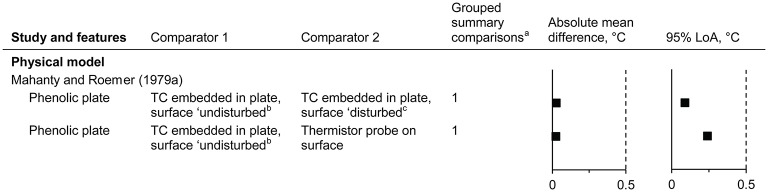
Temperature disturbance of the surface underlying a surface sensor (absolute mean difference and 95% limits of agreement). LoA, limits of agreement; TC, thermocouple. Dashed vertical lines indicate the thresholds for guiding practical significance. aFrom the forest plots in the Supplementary Material; mean differences are presented here as absolute values, indicative of magnitude but not relative direction. bThermocouple 0.4 mm below the plate surface; temperature at the surface calculated by assuming linear variation in temperature through the plate. cTemperature as in “b,” but while a surface temperature probe is in contact with the surface.